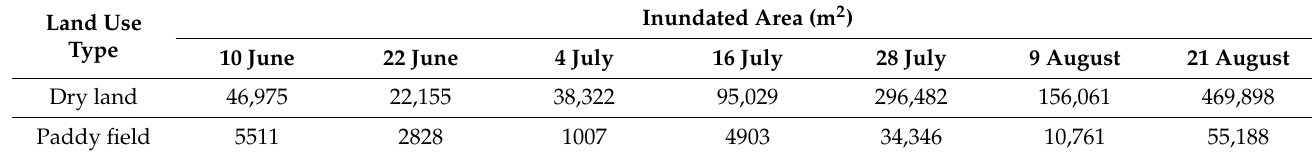
Table 6. Inundated areas of dry land and paddy field in Huangjin River watershed. Land